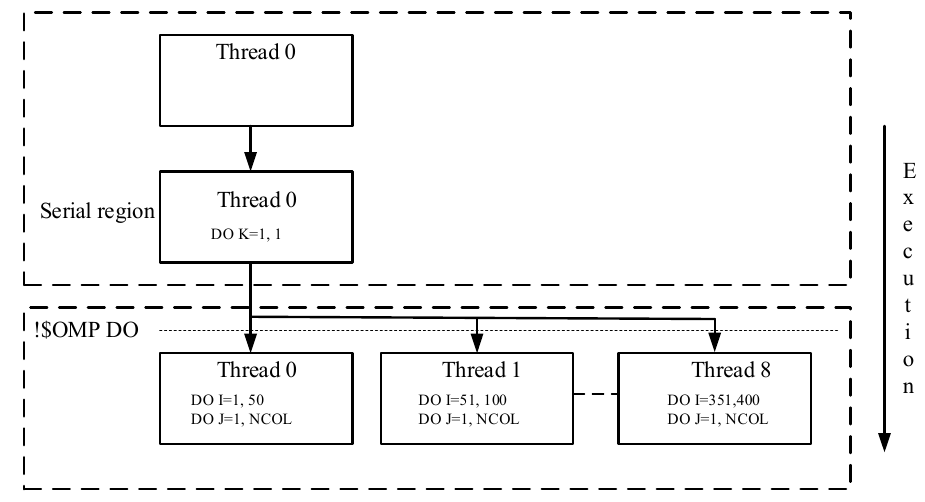
Figure 3. The parallelization of the three-level nested DO-Loop in the case of number of layers < number of processors.